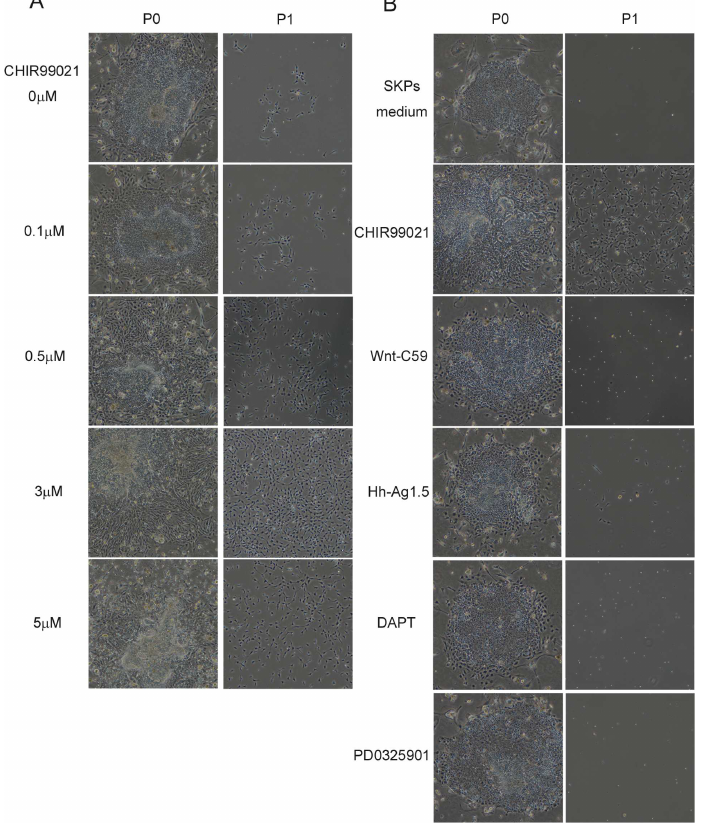
Fig 2. Human SKPs induction is driven by WNT activation. (A) Effective concentration of CHIR neededto inducehiPSC-SKPs. (B) Effects of modifiersused to inducehiPSC-SKPs. After nogginand SB treatment for 5 days, cells were culturedin SKPs medium with signalactivators or inhibitorsas noted for 4